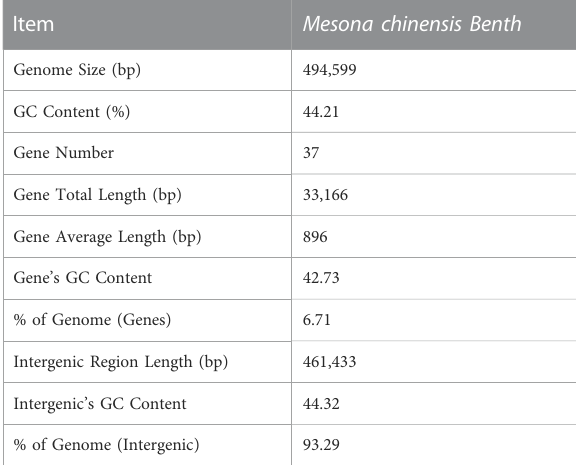
TABLE 1 Assembly statistics for the Mesona chinensis Benth mt genome.